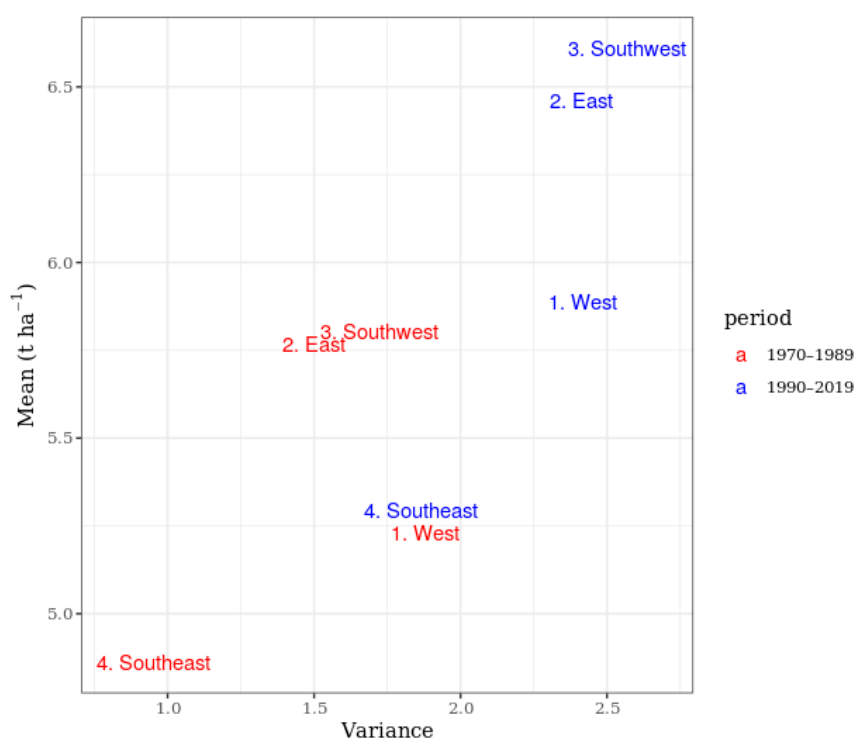
Figure 6. Variance-mean plot of maize yields for the investigated regions and periods.